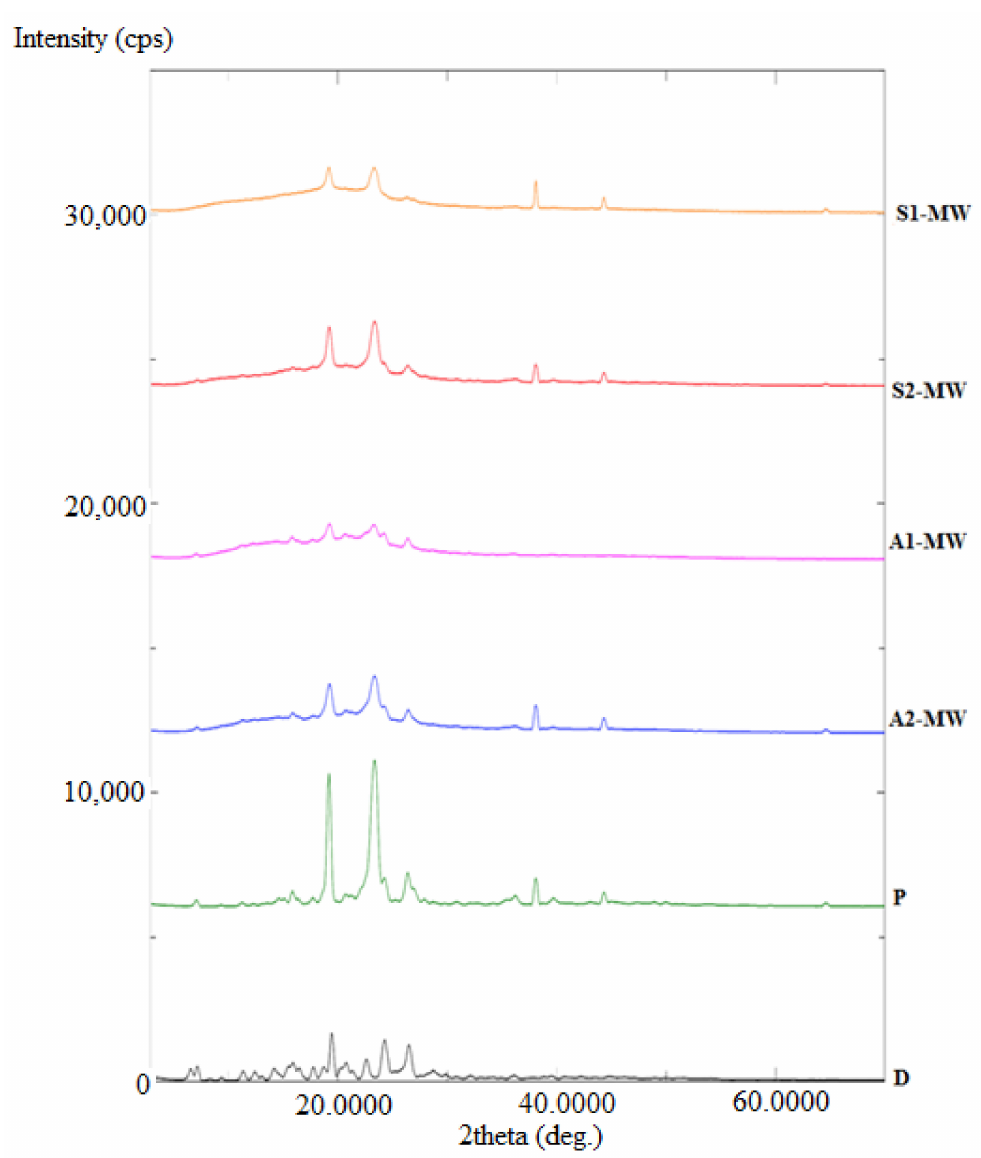
Figure 8. PXRD spectra for pure Gef and different Gef-SDs formulations prepared using microwave